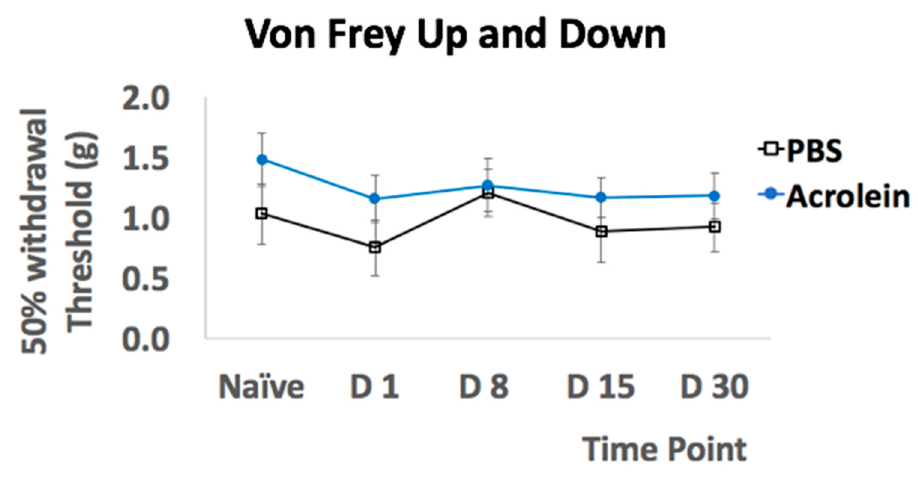
Figure 5. Assessment of mechanical allodynia presented by a 50% withdrawal threshold. Grimace scale to determine a facial expression of pain did not reveal any significant difference. The fourth behavioral assessment was to evaluate the behavioral status of (1) placing and stepping; (2) righting reflex; (3) spinal symmetry; (4) symmetric ablation; (5) lean; (6) hunched back; (7) catalepsy; (8) tremor; and (9) seizures by using the daily parameter score system (Supplementary Figure S1). In addition to this assessment, up to four mice in either the PBS and acrolein group were scored for (1) placing and stepping; (2) leaning; and (3) having a hunched back. None of the mice in the PBS and acrolein groups were scored “1” and “2” with regard to the behavioral status of (1) righting reflex; (2) spinal symmetry; (3) symmetric ablation; (4) catalepsy; (5) tremor; and (6) seizures (Supplementary Figure